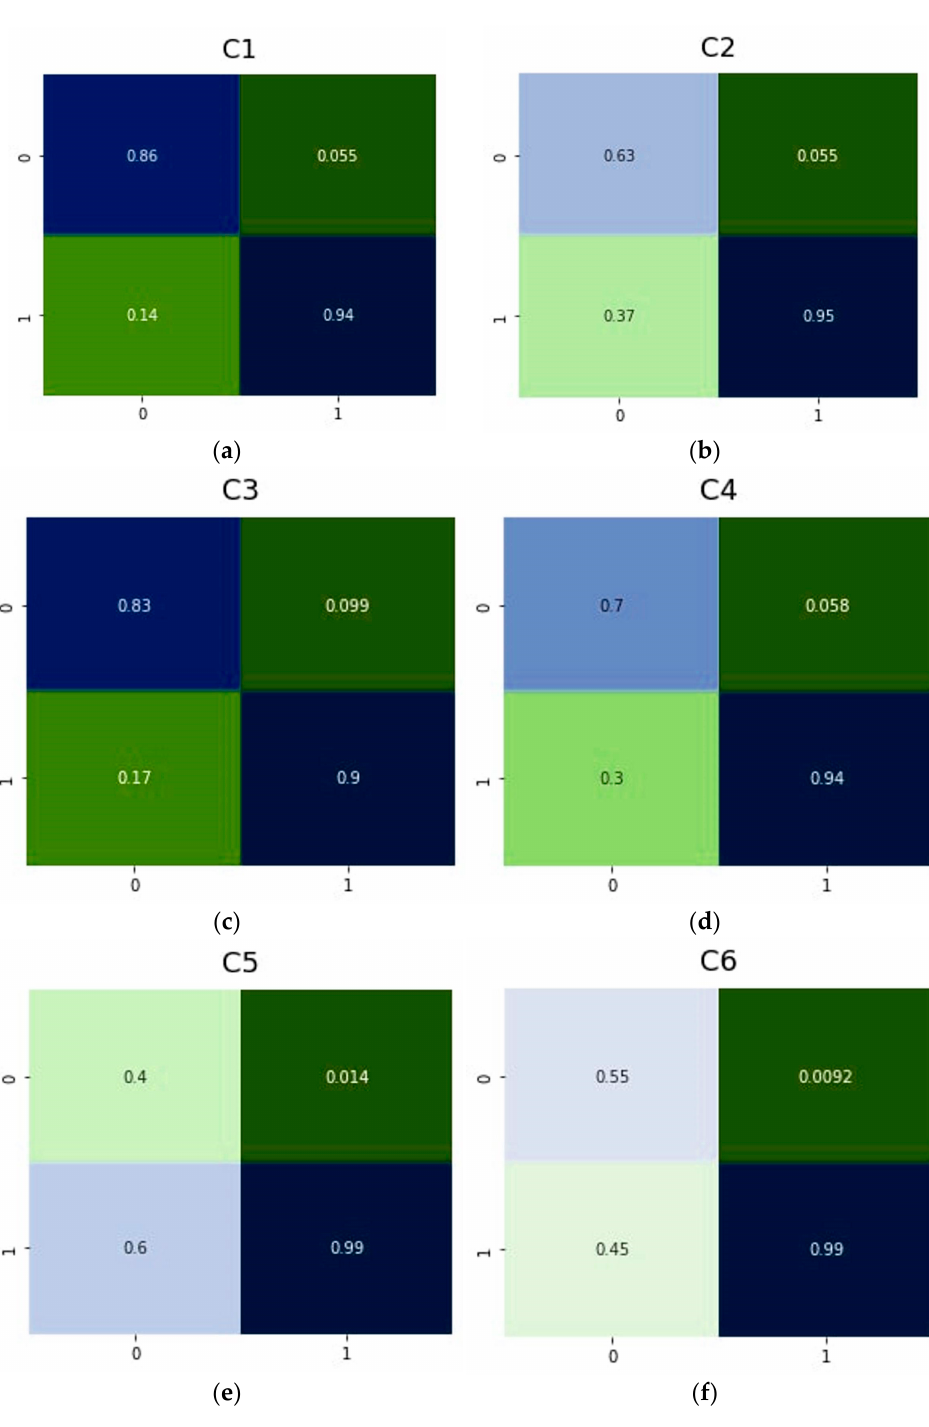
Figure 14. The multi-classification model based on DeiT. The confusion matrices for C1 ( a ), C2 ( b ), C3 ( c ), C4 ( d ), C5 ( e ), and C6 ( f ) classes.